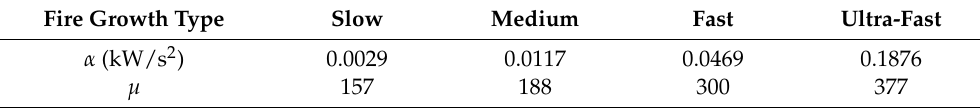
Table 11. Fire growth factor, α , and the coefficient, µ